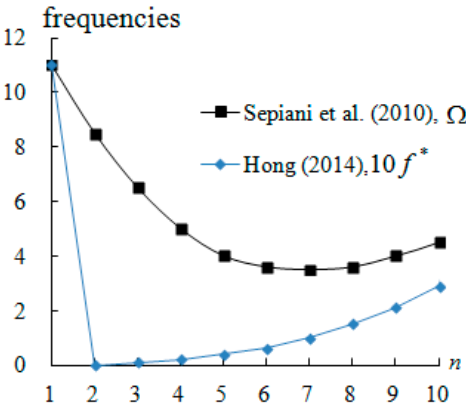
* 10 f ∗ and Ω ) versus n Ω and ) versus n . Figure 3. Compared frequency values (10 f